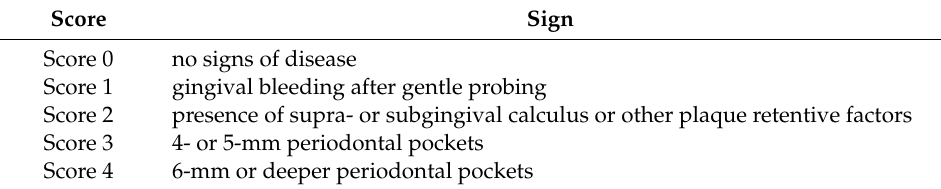
Table 4. Clinical assessment of periodontal status carried out by Community Periodontal Index